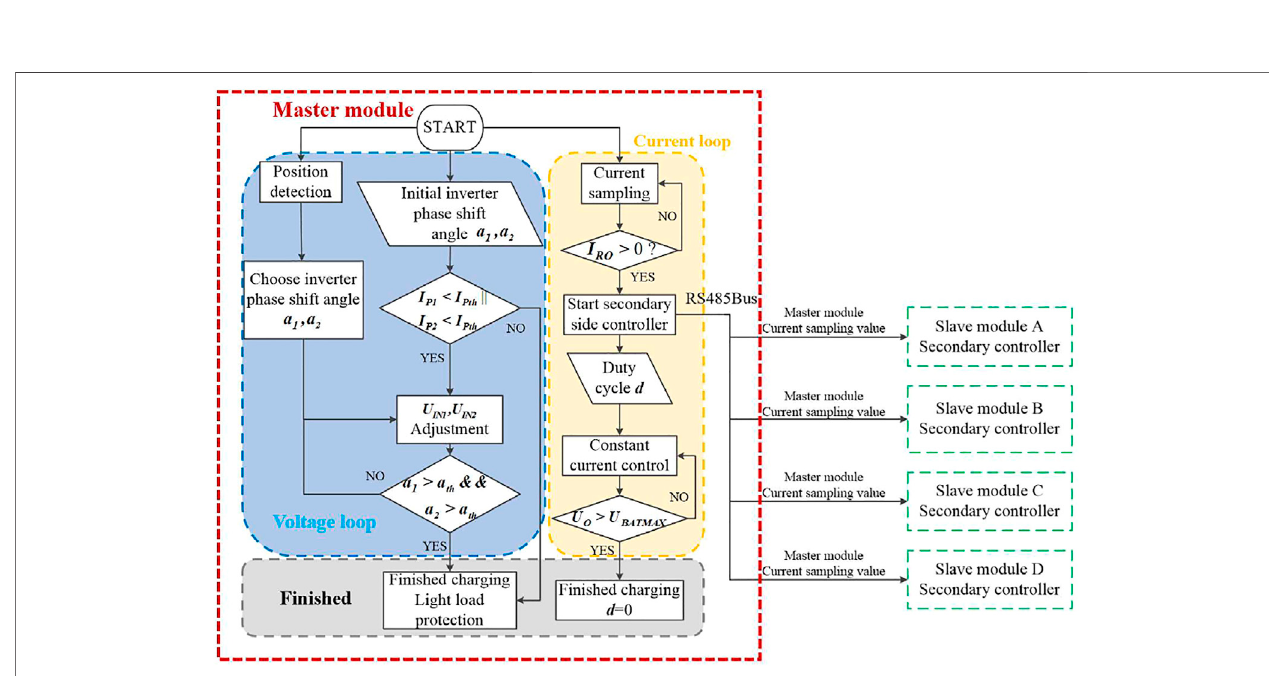
FIGURE 16 | Design of the primary side control system in